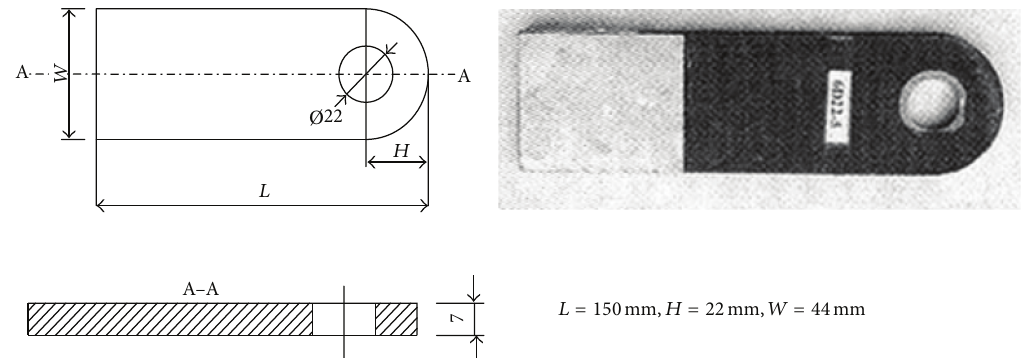
Figure 11: Single ear three-dimensional woven joint specimen and size.